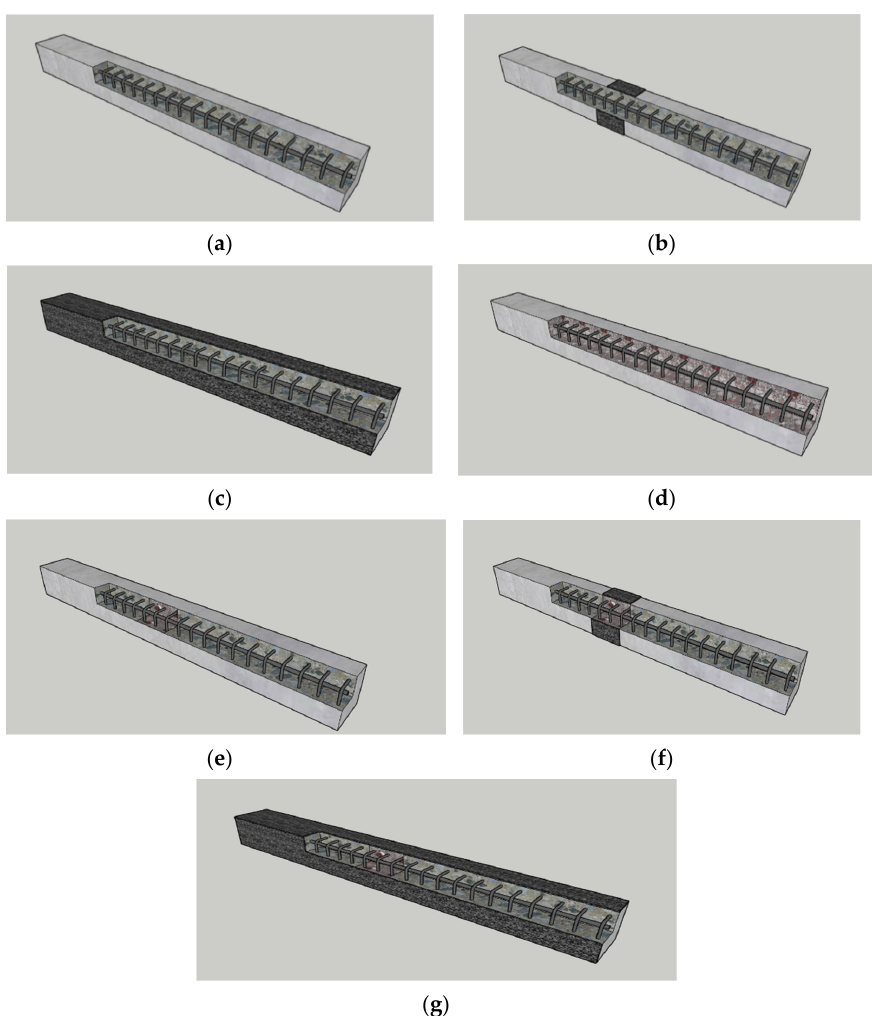
Figure 4. Schematic representation of beam specimens. ( a ) Conventional beam. ( b ) Conventional beam with CFM at PHL. ( c ) Conventional beam with CFM for full length. ( d ) Steel fiber reinforced concrete (SFRC). ( e ) SFRC only at PHL. ( f ) SFRC and CFM at PHL. ( g ) Carbon fiber mesh (CFM) jacketing for total length with SFRC at plastic hinge